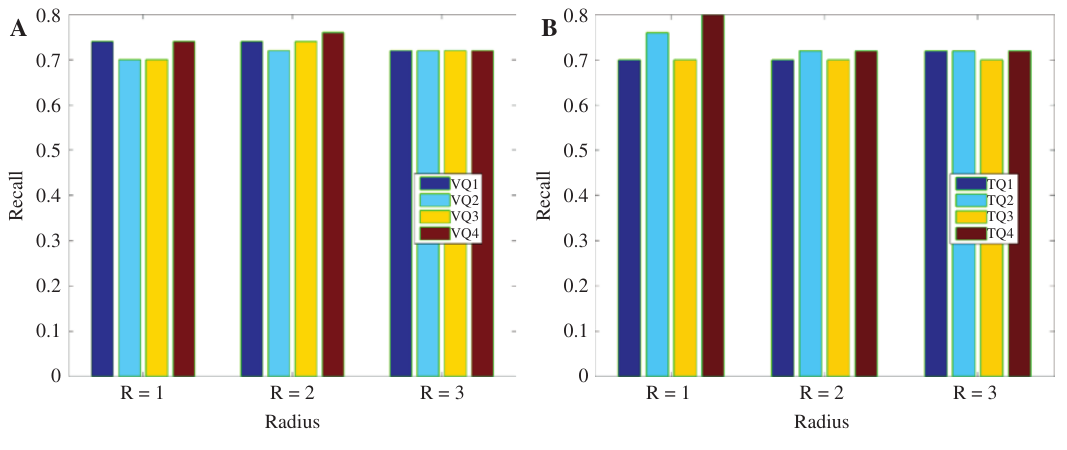
Figure 10: Recall Graph. (A) Video queries. (B) Text